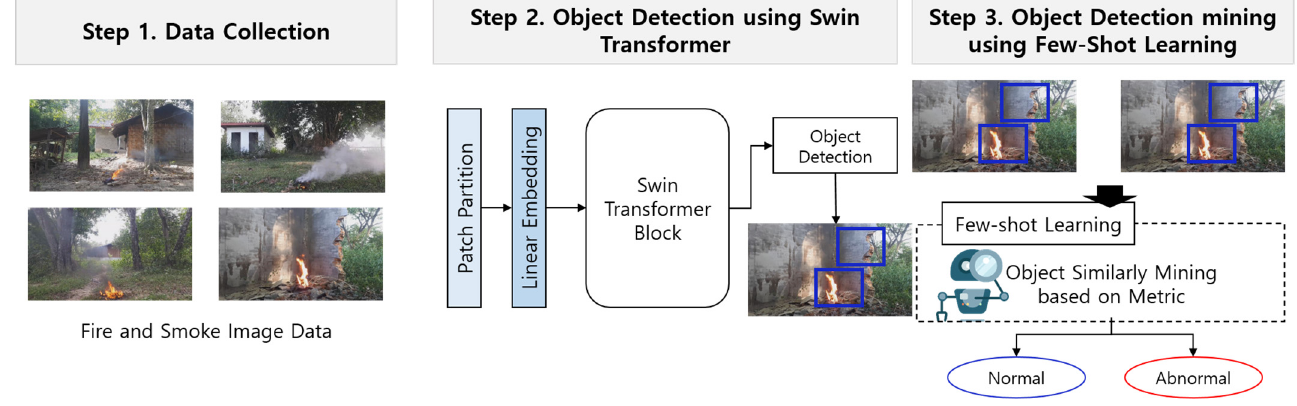
Figure 3. The process of the proposed Swin Transformer-based object detection model using explainable meta-learning mining.